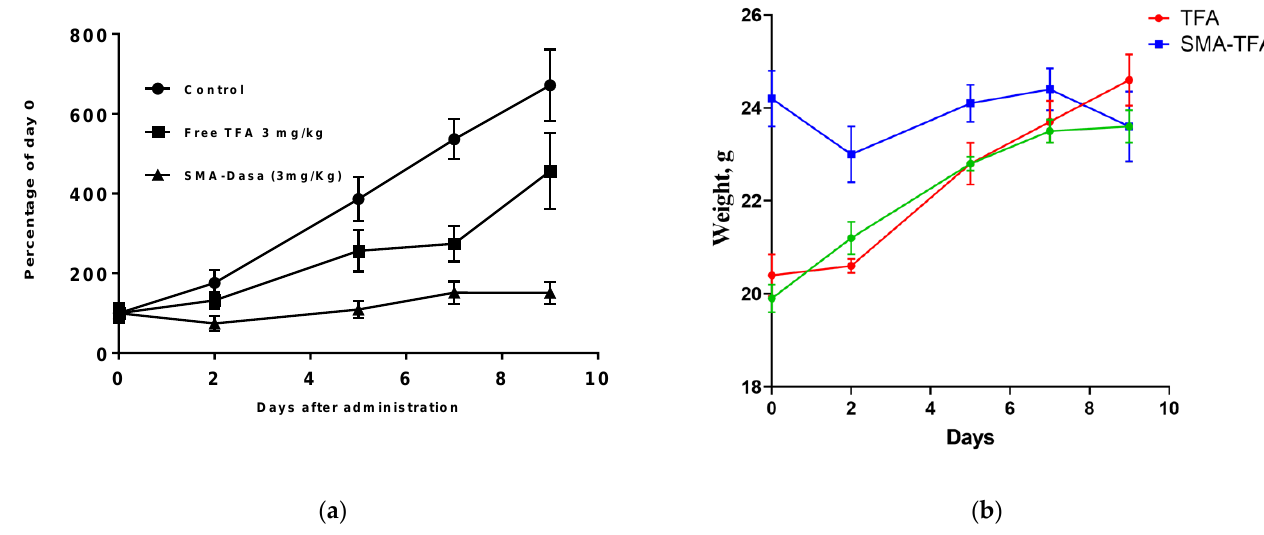
Figure 4. In vivo antitumor activity of TFA and SMA – TFA on 4T1 tumor-bearing Balb/c mice. Mice were treated for 9 days with either TFA (3 mg/kg) and SMA – TFA (3 mg/kg). The control group was injected with PBS (pH 7.4). ( a ) Tumor volume changes and ( b ) body weight changes were monitored over the treatment period. Data are presented as the mean of triplicate experiments ± standard error.